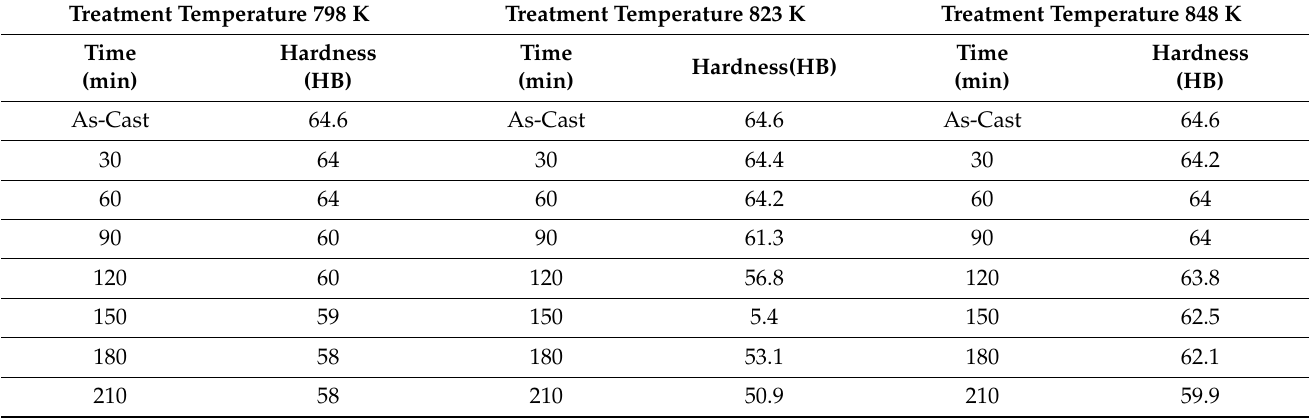
Figure 6. Ratio of alpha and beta phase percentage with respect to time at different homogenization temperatures. Table 3. Values obtained of Brinell hardness (HB) of the studied alloy at different times and tempera- tures of homogenization